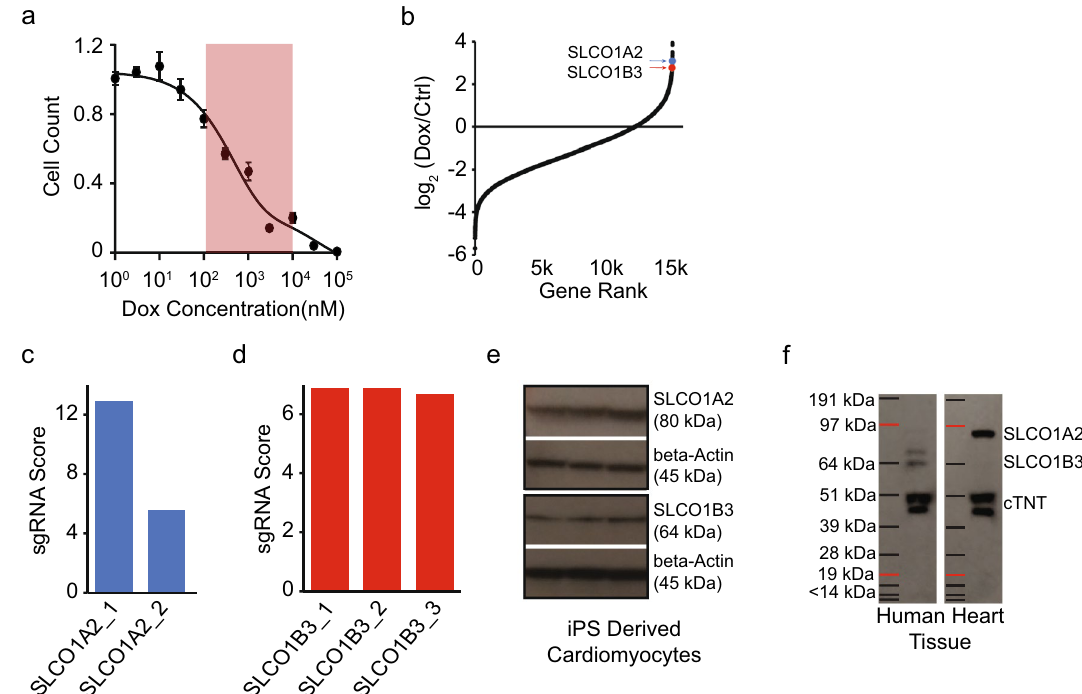
Figure 3. Genome-scale CRISPR/Cas9 screen in iPS derived cardiomyocytes for mediators of doxorubicin- toxicity. ( a ) Dose response curve for doxorubicin-toxicity in iPS derived cardiomyocytes (circulating concentration range highlighted in red, n = 8 per condition). ( b ) Distribution of fold change scores in doxorubicin (dox) versus control (ctrl) treated cardiomyocytes. SLCO1A2 and SLCO1B3 indicated by blue and red arrows, respectively. ( c ), and ( d ) Enrichment scores for individual sgRNAs targeting SLCO1A2 and SLCO1B3. ( e ) Western-blot for protein expression of SLCO1A2 and SLCO1B3 in human iPS derived cardiomyocytes. Full-length blots are included in Supplementary Figure 10a–b. ( f ) Western-blot for protein expression of SLCO1A2 and SLCO1B3 in human heart tissue. Full-length blots are included in Supplementary Figure